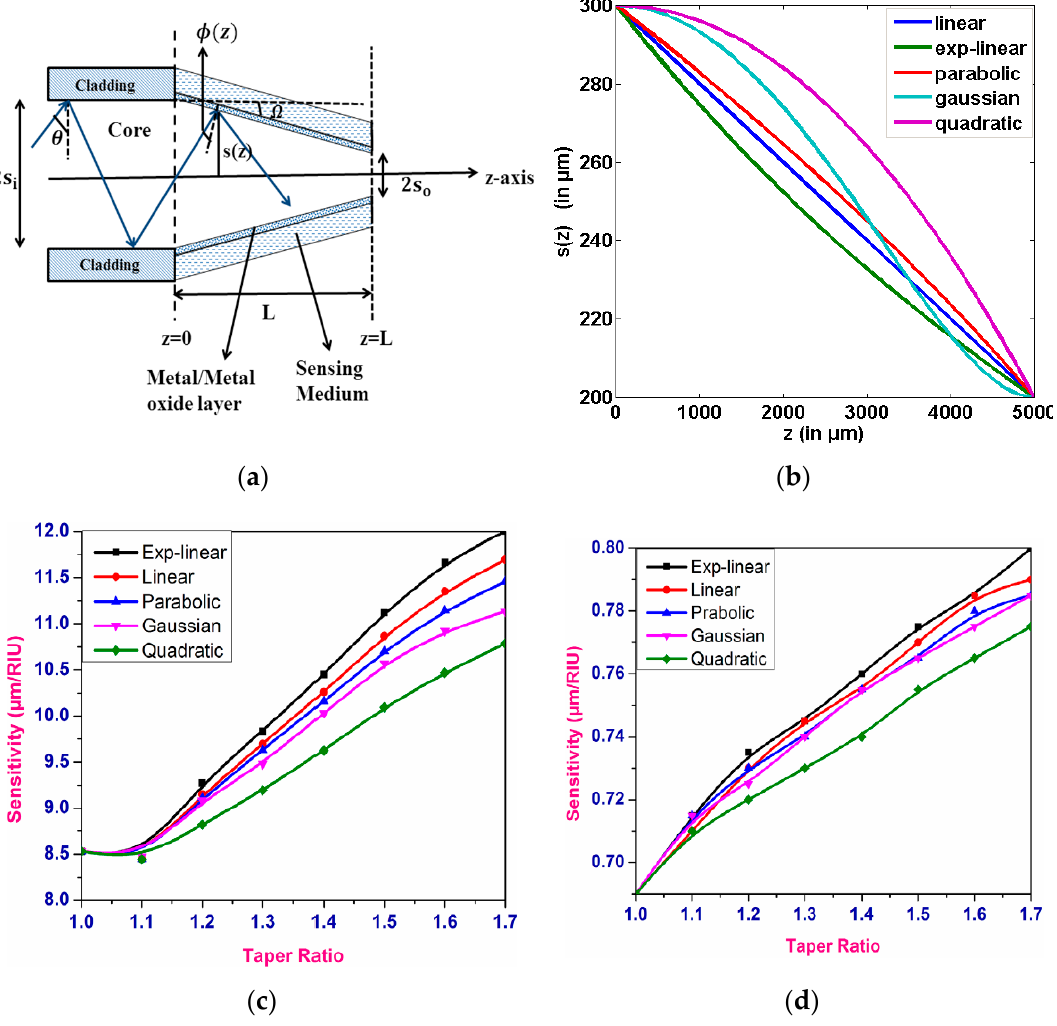
Figure 4. ( a ) Structural view of used tapered-core fiber optic probe; ( b ) variation of the taper radius s ( z ) with distance z for five different taper profiles. Graphical presentation of sensitivity with TR along with five taper profiles for ( c ) first and ( d ) second LMR of ITO, respectively. Reproduced with permission from [74], copyright IOP Publishing.